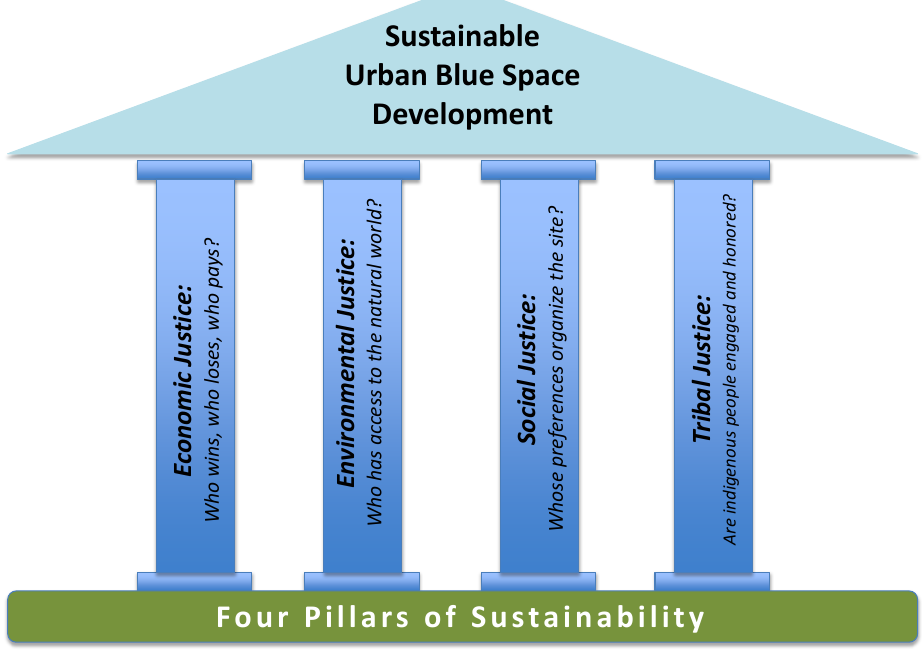
Figure 1. Four pillars of sustainable development for urban blue space. Sustainable Urban Blue Space